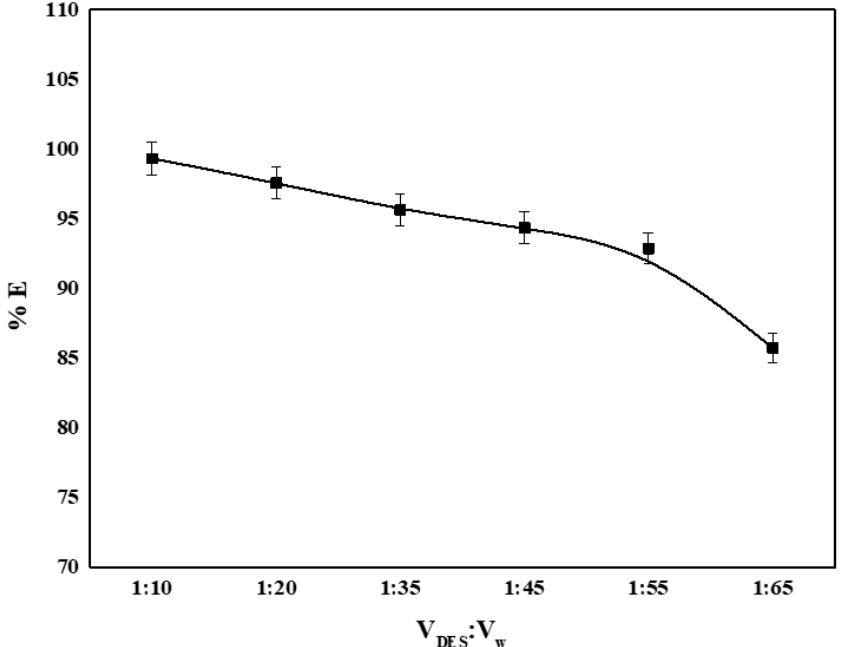
Figure 4. Effect of vortex mixing time on MB extraction efficiency. [MB] = 200 mg dm − 3 ; T = 25.0 °C.